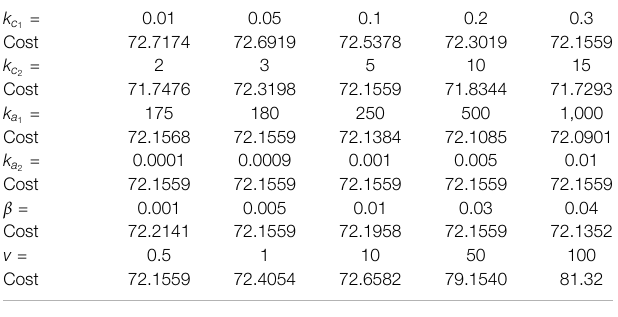
TABLE 2 | Sensitivity Analysis for the two state system.